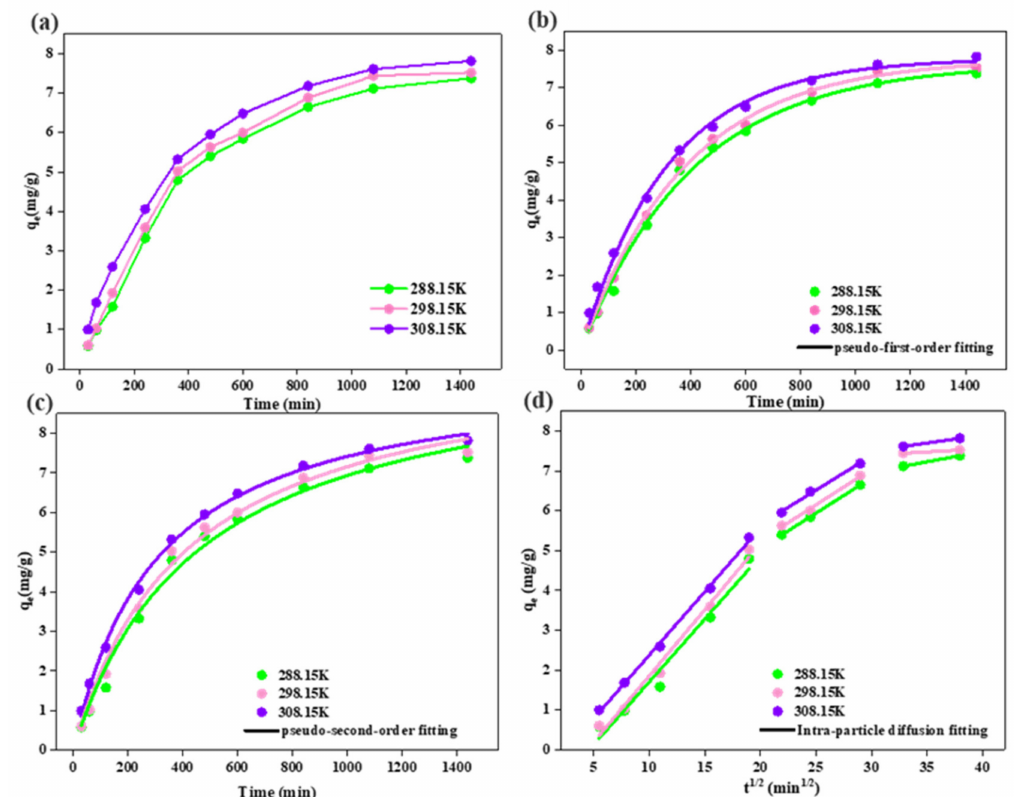
Figure 5. ( a ) E ff ect of time on CIP adsorption by CA-Al-KABs, ( b ) the pseudo-first-order fitting plots of adsorption kinetic model, ( c ) the pseudo-second-order fitting plots of adsorption kinetic model, ( d ) the fitting plots of intra-particle di ff usion model (pH: 4, initial CIP concentration: 20 mg · L − 1 , m / v: 0.04 g / 50 mL). q e , the equilibrium adsorption